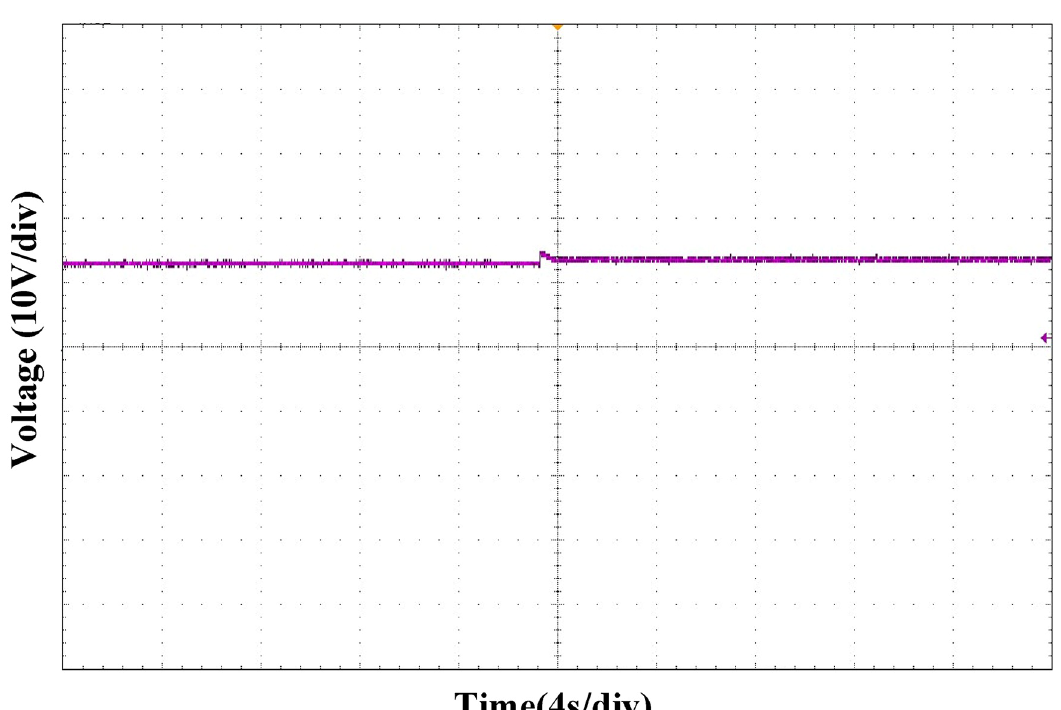
Fig 28. Load switching waveform under ATSMC control strategy.